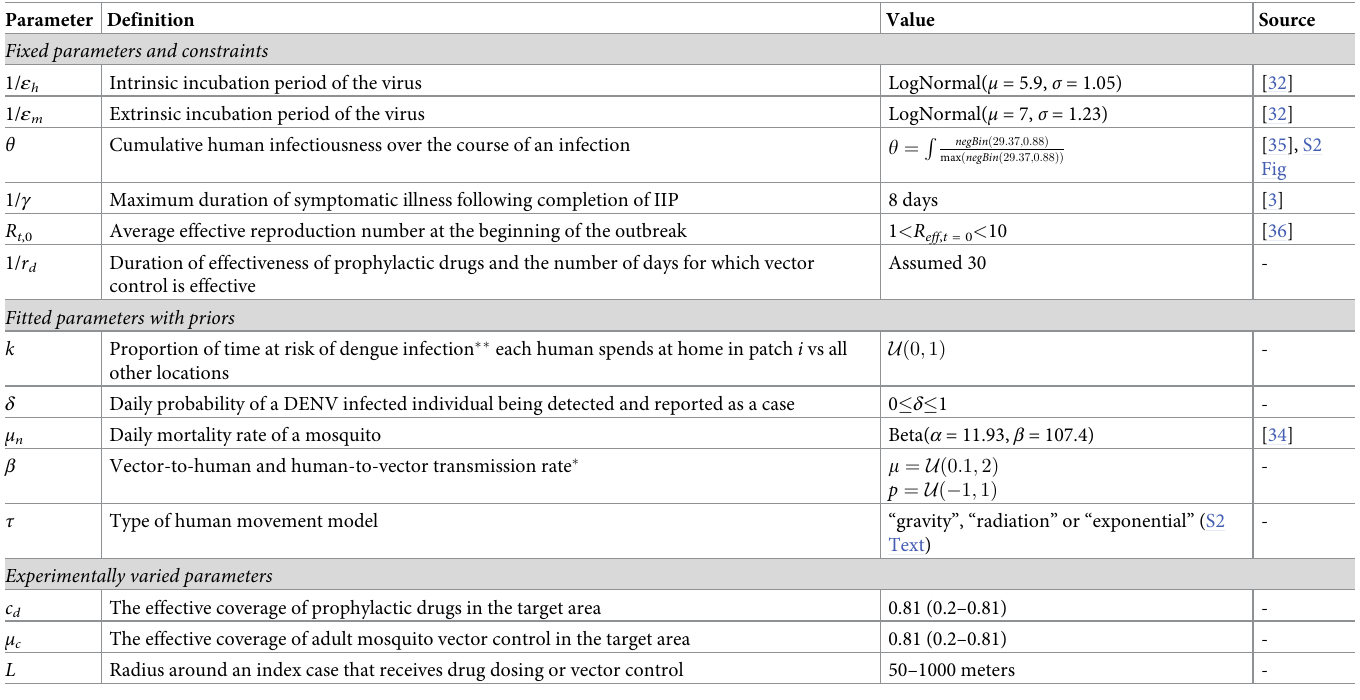
Table 1. Model parameter